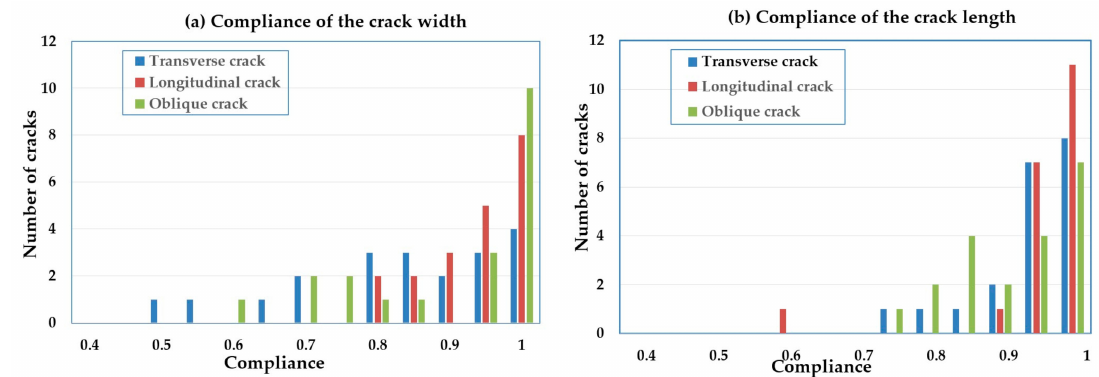
Figure 14. The histogram of length and width compliance of cracks in 60 samples. ( a ) Compliance of the crack width, and ( b ) compliance of the crack length.